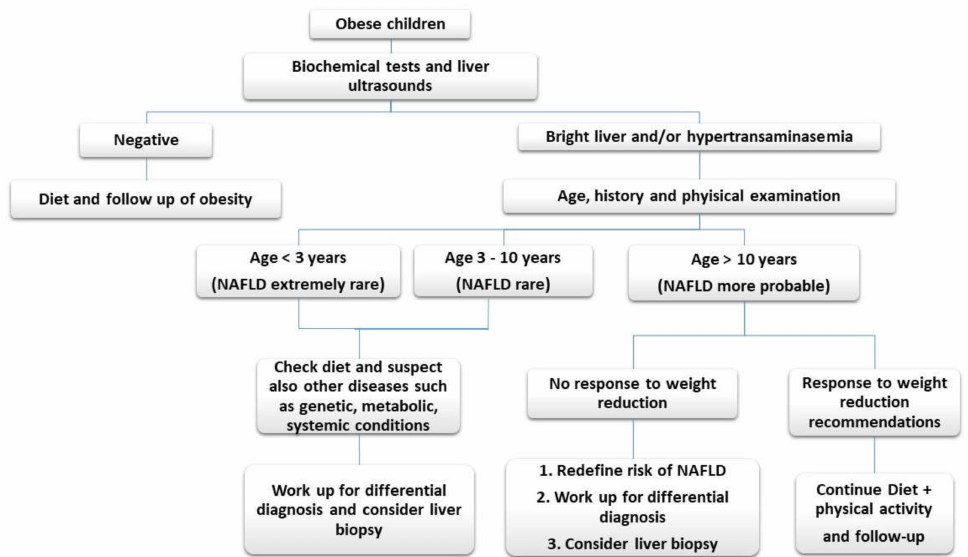
Figure 1. Algorithm for differential diagnosis of fatty liver disease in